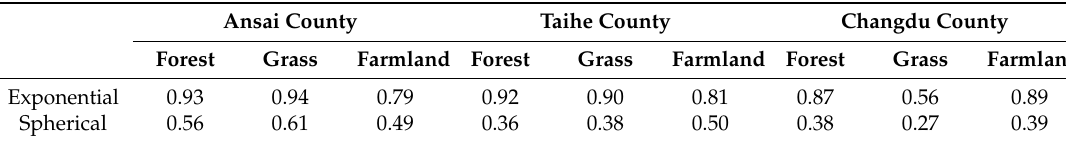
Table 4. R 2 values for the exponential and spherical models.